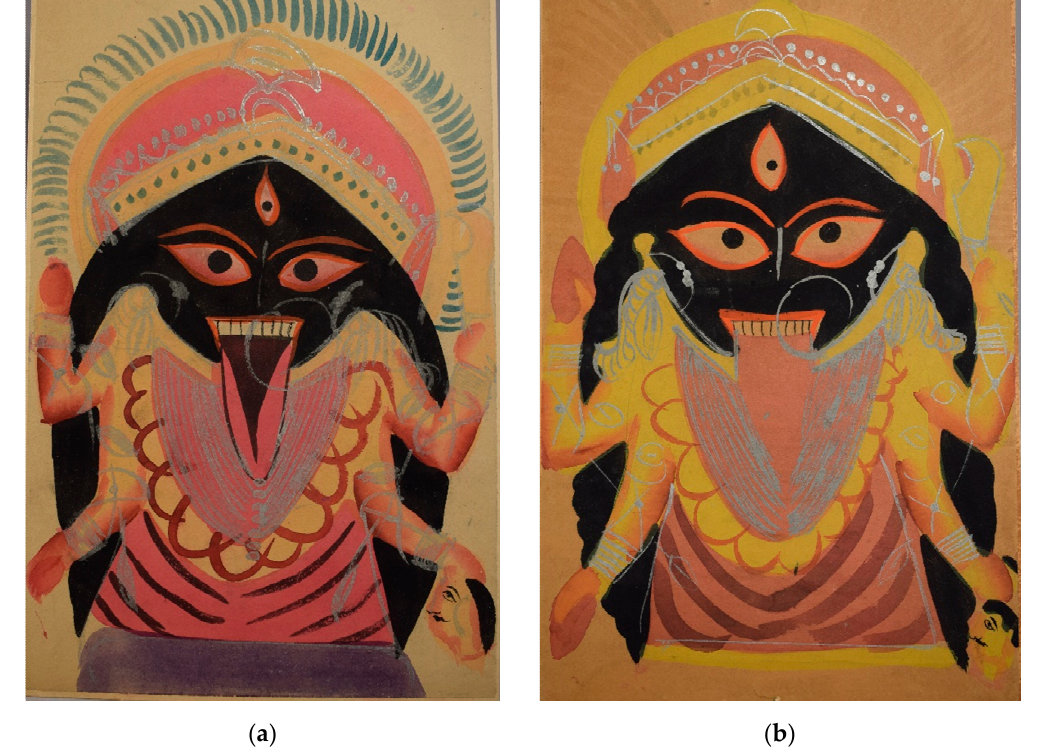
Figure 4. Bengali K ā ligha ṭ paintings of Durg ā /K ā l ī in the Marburg Museum of Religion (acc.nr. B-Kp 037 ( a , b ); accquired by Otto in the early 20th ct. Photo by Heike Luu). Rudolf Otto, founder of the museum, referred to these images in the first German editions of Das Heilige ( The Idea of the Holy ) to illustrate the tremendum , a “repellent”, “horrible and dreadful” feeling of “authentic religious awe” towards the Divine Wrath , which he claimed to be archetypical for religious experience in general (Otto [1917] 1958, p. 62). Adapted with permission from Heike